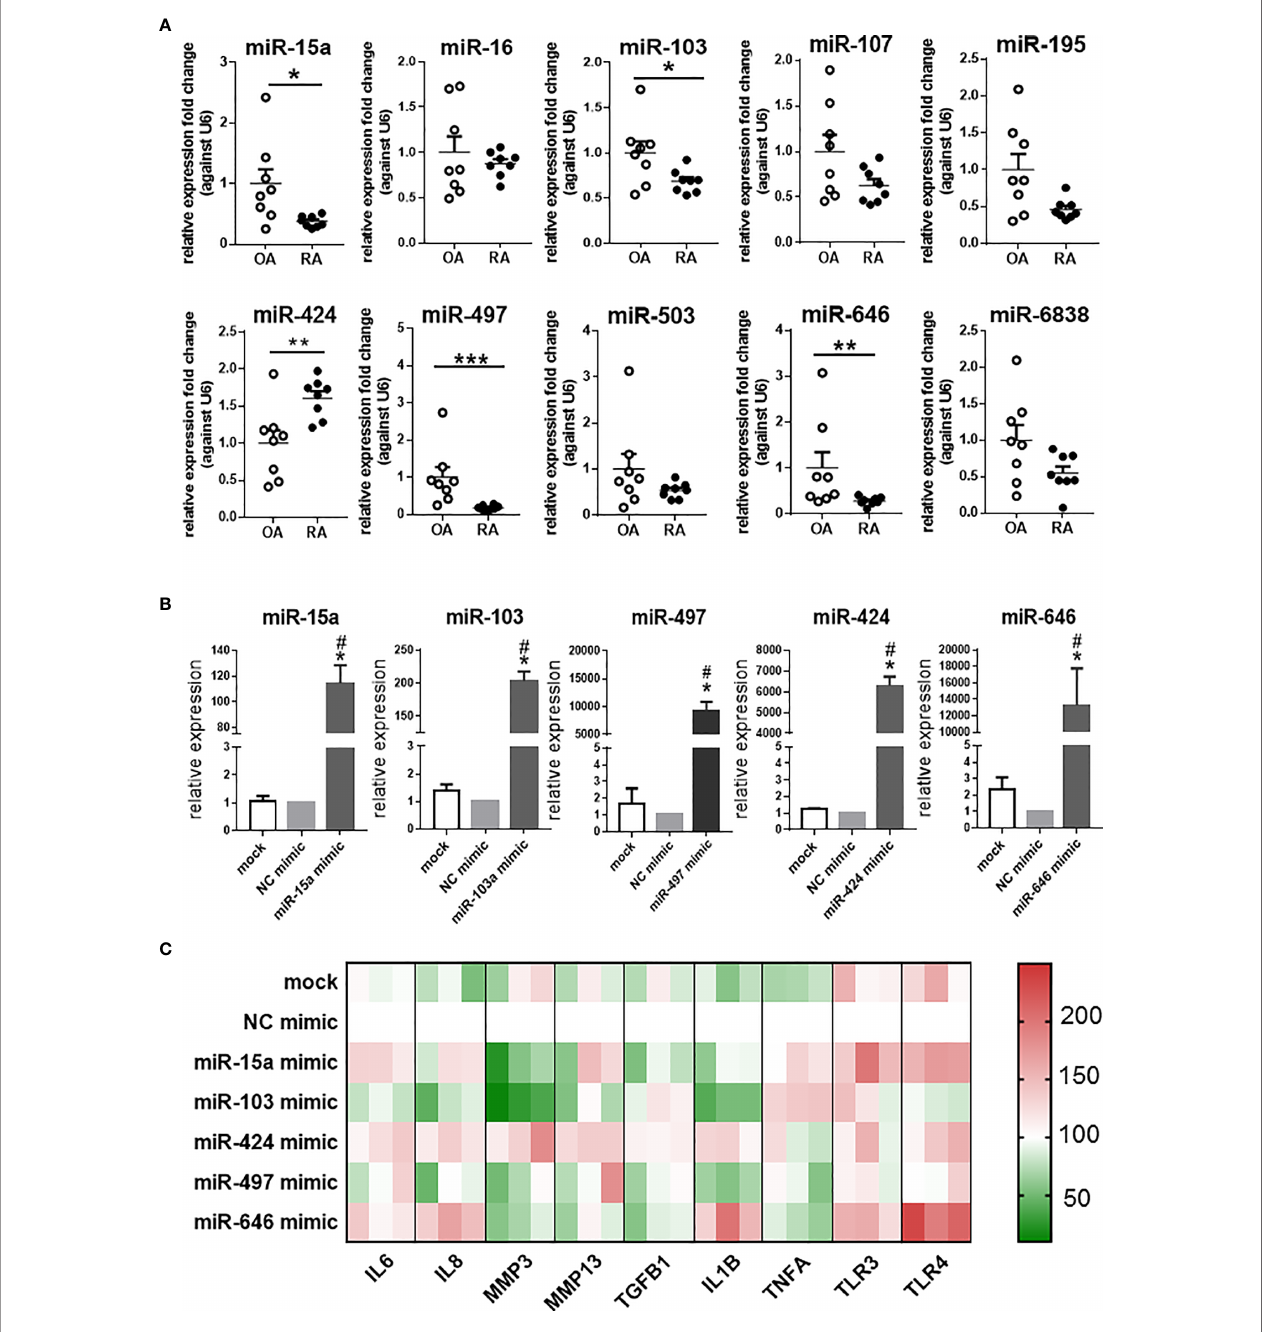
FIGURE 1 | The expression of miR-15/107 family in RA and OA synovial tissues and pro-in fl ammatory cytokines, MMPs, Toll-like receptors in SW982 cells. (A) The expression of 10 mature miR-15/107 family members in human synovial tissue form RA or OA patients determined by using RT-qPCR. (B) The expression of 5 miRNAs after transfected with 10 nM mimics determined by using RT-qPCR. (C) The expression of pro-in fl ammatory cytokines ( IL1B, IL6, IL8, TNFA, TGFB1 ), MMPs ( MMP3, MMP13 ) and Toll-like receptors ( TLR3, TLR4 ) determined by RT-qPCR and the results were shown through heatmap, each color block in the heatmap represents an independent cell experiment. Red, green, and white signals indicate relatively high, low, and baseline (mock group) expression levels. (A) Bar represents mean ± SEM of samples from OA and RA patients (both n = 8). (B, C) : Bar represents mean ± SEM from three independent cell experiments in SW982 cell. Triplicates were used for each transfection and RT-qPCR experiment. Mann-Whitney U test (*** P < 0.001, ** P < 0.01, * P < 0.05), *: vs. NC mimic, #: vs.